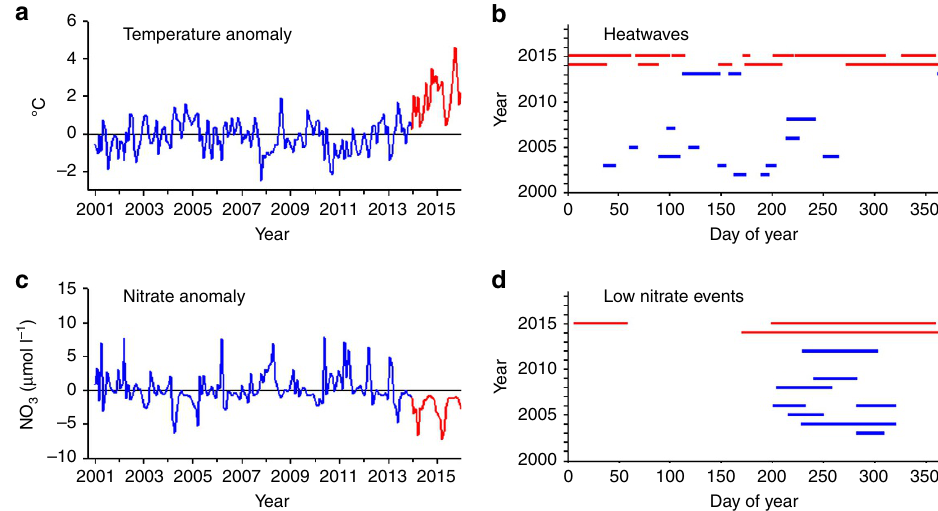
Figure 1 | Anomalies in ocean temperature and nitrate in the Santa Barbara Channel. Monthly anomalies in ( a ) bottom temperature at 7–10m depth and ( c ) bottom nitrate concentrations at 7–10m depth. Occurrence and duration of ( b ) heatwaves defined as five or more consecutive days when the mean bottom temperature was warmer than the 90th percentile and ( d ) low nitrate events lasting at least 21 days with mean daily bottom nitrate concentrations o 1 m moll (cid:2) 1 . The anomalously warm years of 2014–2015 are shown in